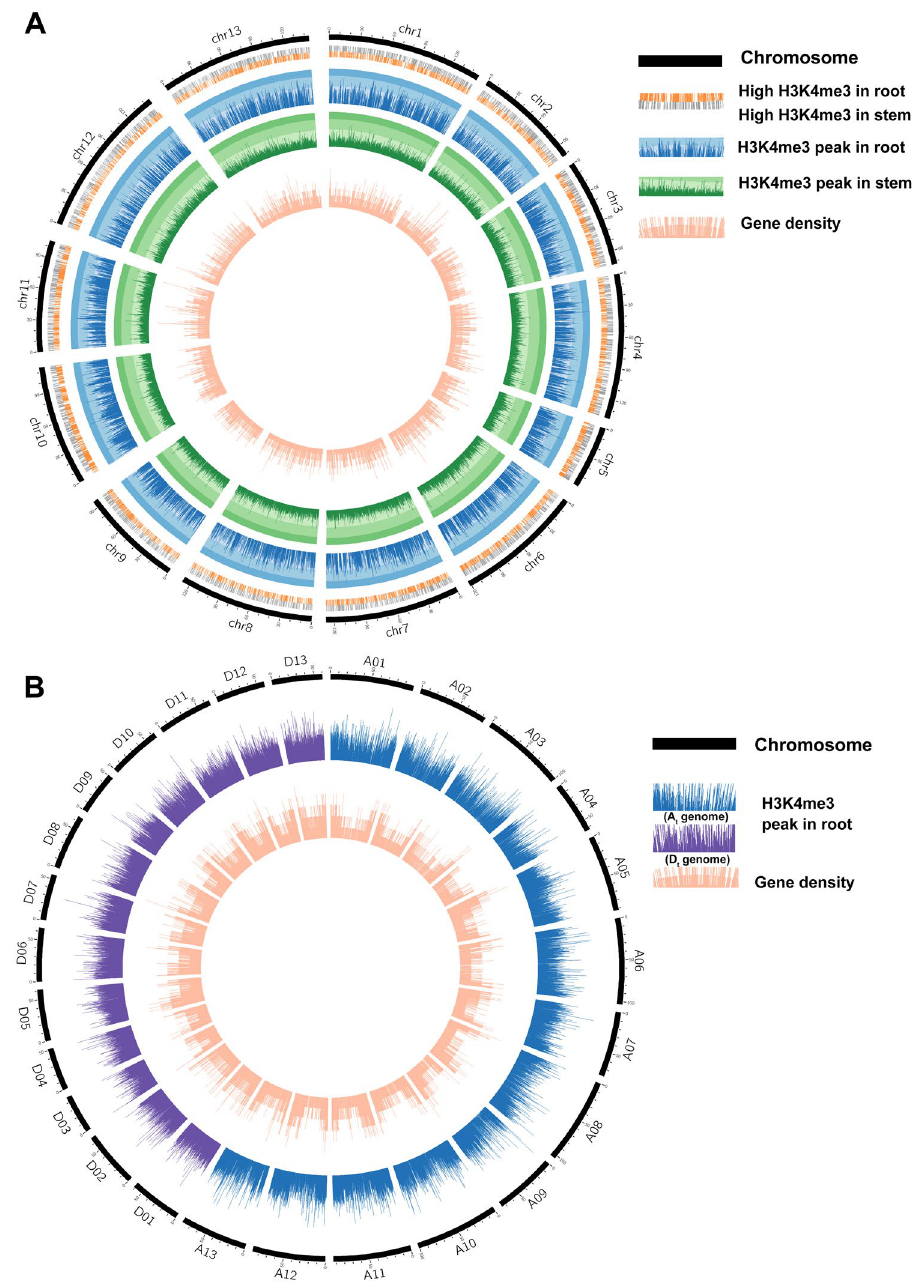
Figure 1. Genome-wide distribution of H3K4me3 and gene density. ( A ) The histone modification peaks of H3K4me3 in root (blue) and stem (green), and gene density (pink) distribution along the whole G. arboreum genome. In the calculation of gene density, 10,000 bp is used as a unit. The peak height indicates the enrichment score of H3K4me3. Histone modification peaks in orange and grey are root-up H3K4me3 peaks and stem-up H3K4me3 peaks, respectively. The differential histone modification peaks were identified by the software MACS, which compared H3K4me3 histone modification density between root and stem. ( B ) The histone modification peaks of H3K4me3 in root and gene density (pink) distribution among the whole G. hirsutum genome. The peaks in blue are in the At genome (donor was G. arboreum ) and peaks in purple are in the Dt genome (donor was G. raimondii ). The unit of gene density is 10,000